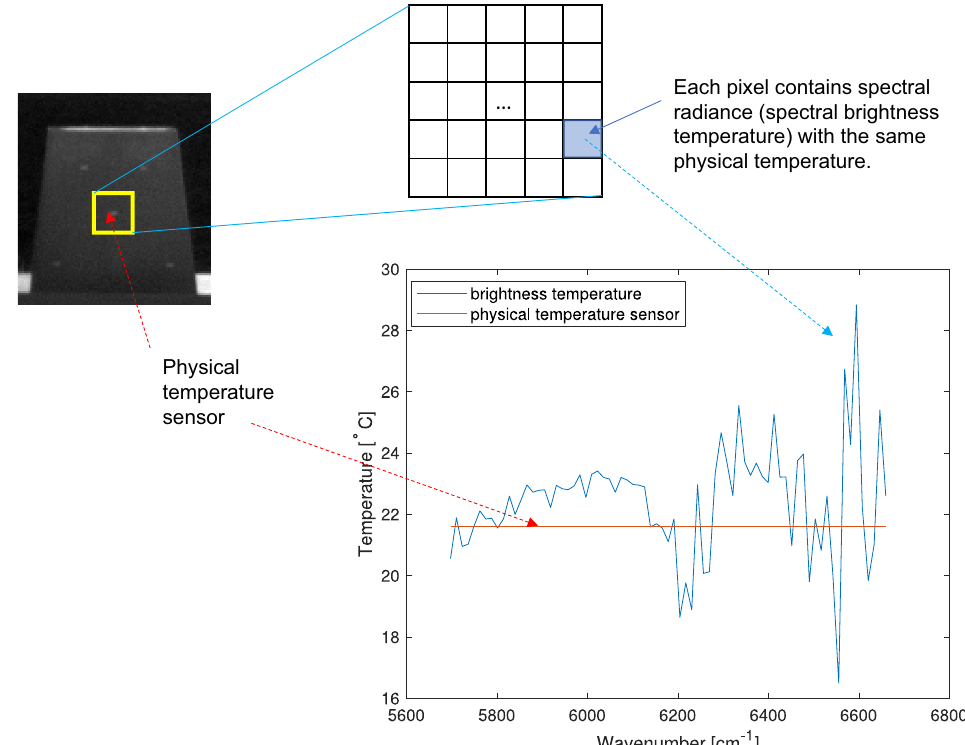
Figure 10. Preparing the spectral brightness temperature and physical temperature pair for deep